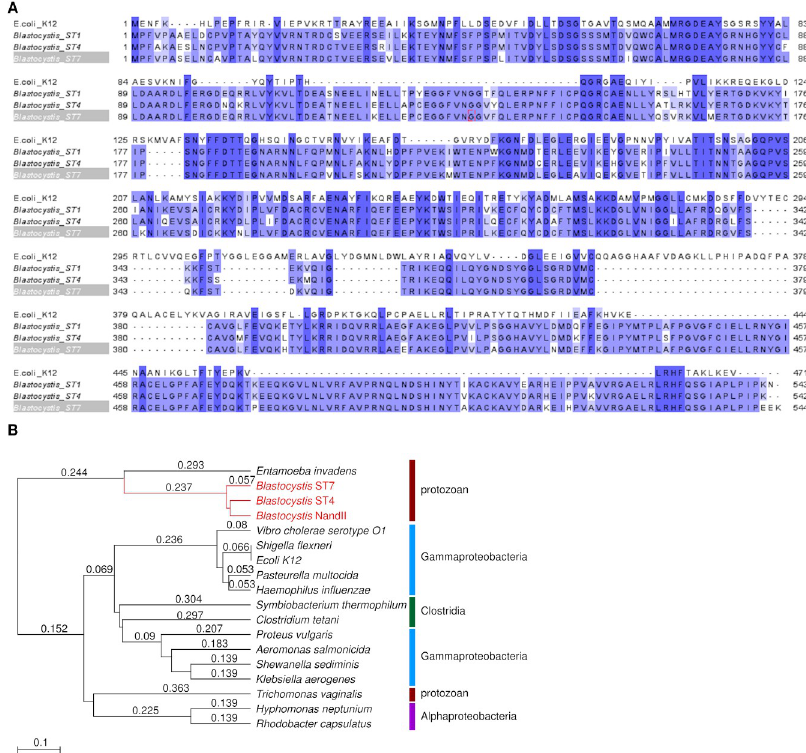
Regions of homology between sequences are highlighted blue. Generated using Jalview [18] B) Phylogenetic tree of TnaA-expressing microorganisms, generated using PhyML [19]. Branches exclusive to Blastocystis subtypes are highlighted in red. Numerical values represent substitutions per site. For sequences used, see Table 1.